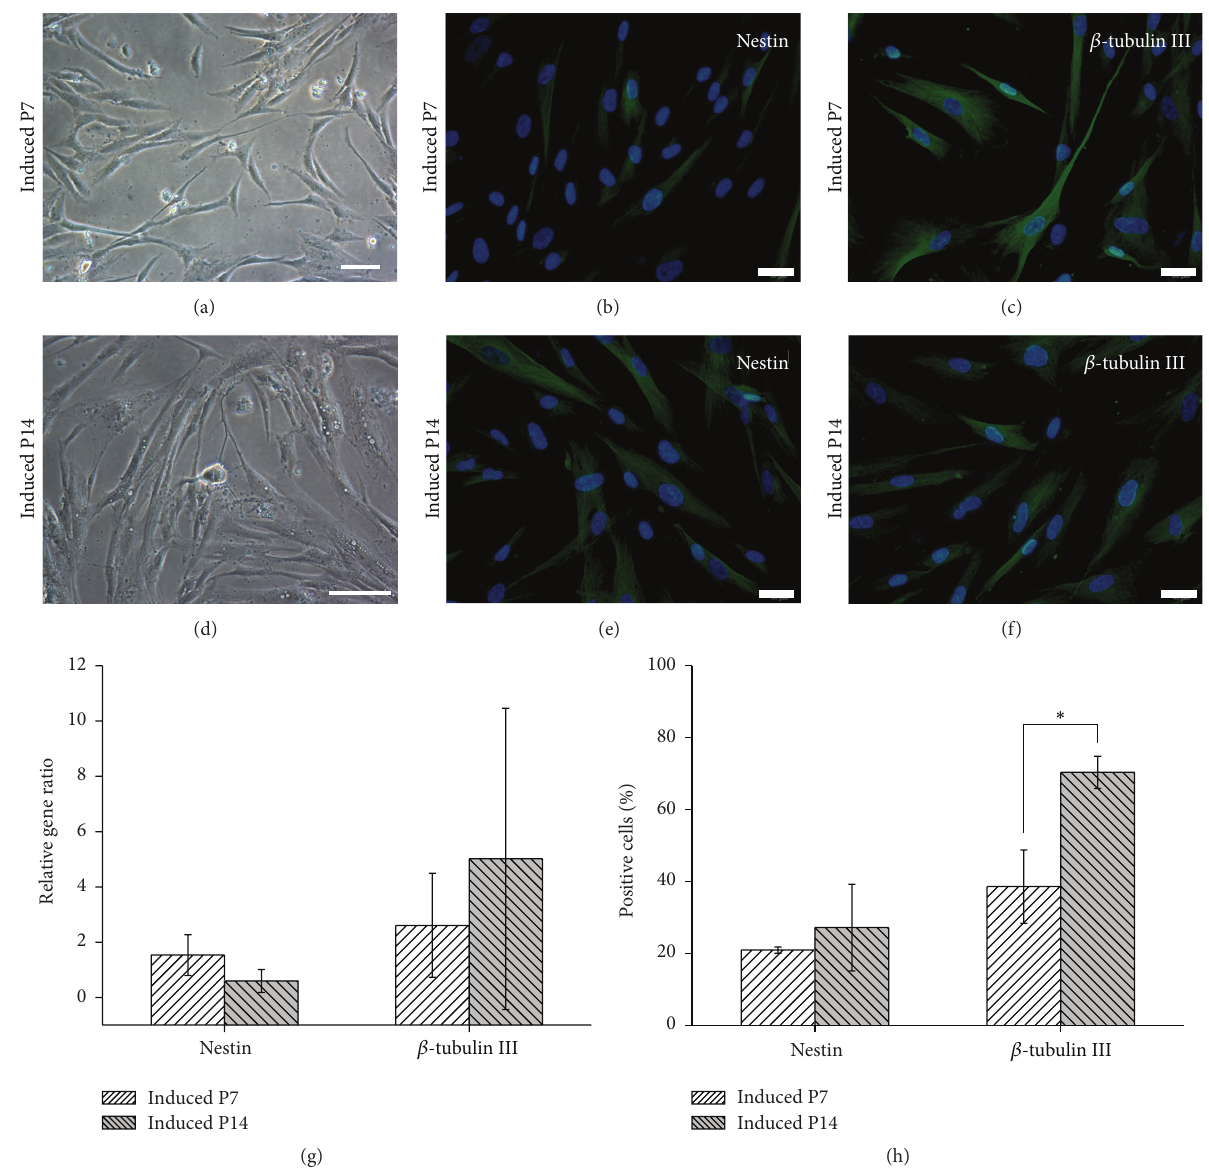
Figure 6: Morphology and expression of neural-specific genes and protein in WJ MSCs (Wharton’s jelly-derived mesenchymal stem cells) in the early and middle phases after neural induction. (a and d) After DMSO and BHA ( 𝛽 -hydroxyanisole) treatment, WJ MSCs in the early and middle phases exhibited a neuronal-like morphology. Bar: 100 𝜇 m. (b, c, e, f) Immunocytofluorescence staining results showed that neural induction significantly increased the protein expression of Nestin and 𝛽 -Tubulin III in induced cells (induced P7 and induced P14). Bar: 50 𝜇 m. (g) The gene expression of Nestin and 𝛽 -Tubulin III was upregulated after neural induction with no significant differences between two groups (induced P7 and induced P14). (h) The percentage of 𝛽 -Tubulin III positive cells in the group of P14 induction ( 70.4 ± 4.5 %) was significantly higher than P7 induction ( 38.6 ± 10.2 %) according to the statistical analysis results ( ∗ 𝑃 < 0.05 ), which indicated that serial passage significantly increased the neural differentiation capability of WJ